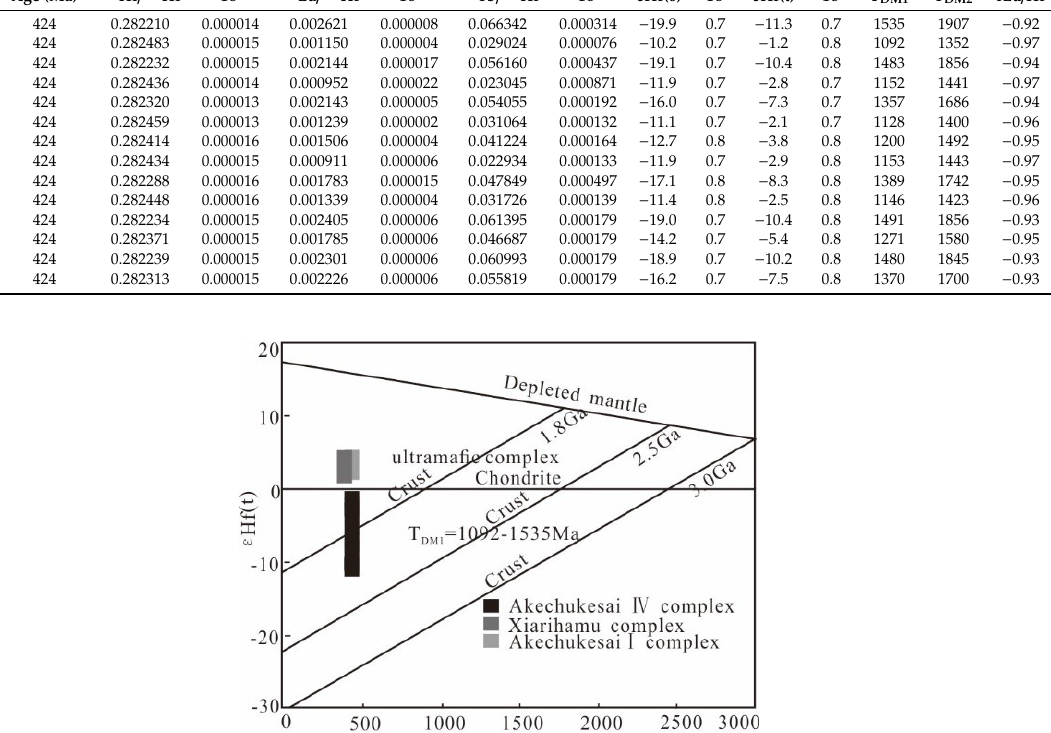
Figure 8. Histogram of S isotopic composition of sulfides from vein-like ore and disseminated ore. Figure 9. Diagrams of 206 Pb/ 204 Pb, - 207 Pb/ 204 Pb, and 206 Pb/ 204 Pb - 207 Pb/ 204 Pb of the sulfides from Akechukesai Ⅳ mafic–ultramafic complex. EM Ⅰ : enriched mantle Ⅰ ; EM Ⅱ : enriched mantle Ⅱ ; MORB: mid-ocean ridge basalt. Data sources: Zart and Doe [24], Allegre et al. [25], Zindler and Hart [26].